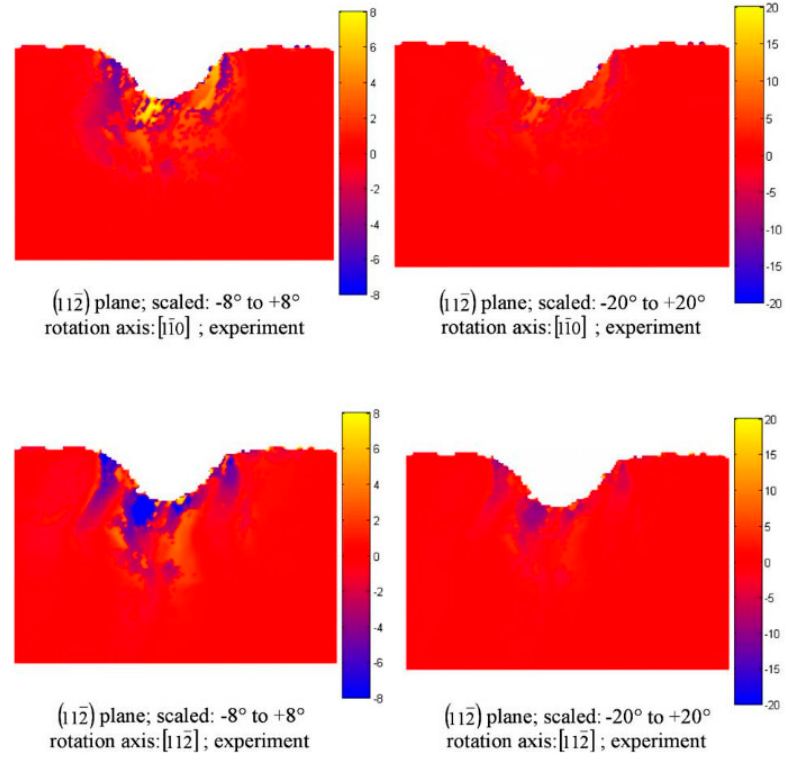
Figure 20. Rotation angles and rotation directions in the (11 2(cid:3364) ) plane [45]. Reproduced with permission from N. Zaafarani et al., Acta Materialia; published by Elsevier,